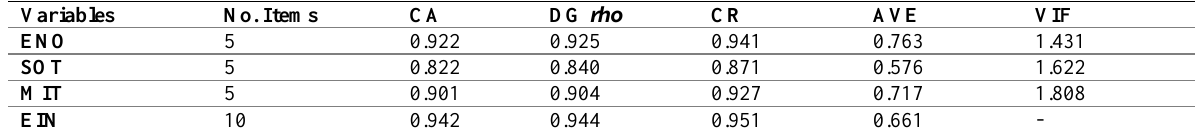
Table 5: Reliability and Validity